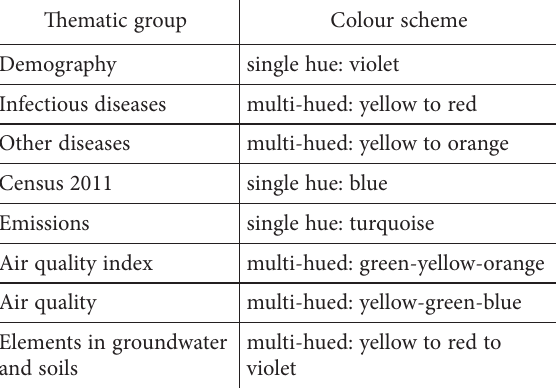
Table 5. Applied colour schemes for thematic groups of data